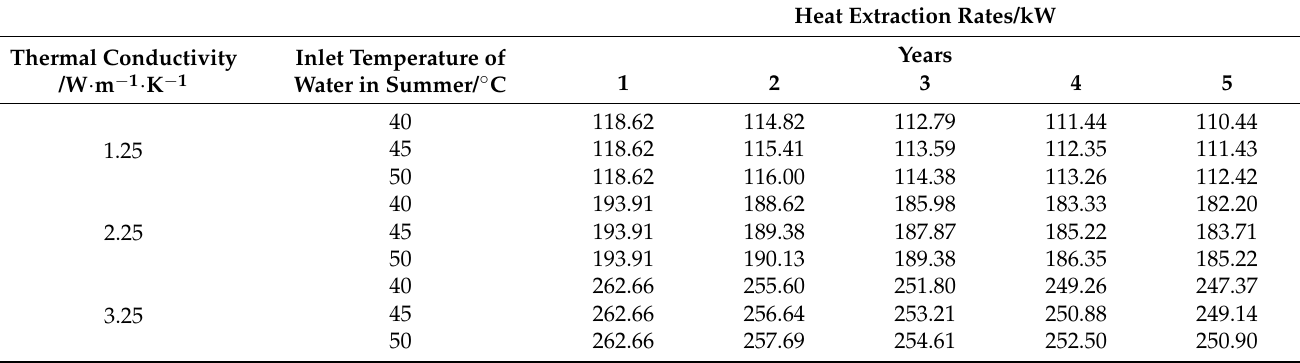
Table 9. Heat extraction of the DBHE system under different thermal conductivities of formation. Heat Extraction